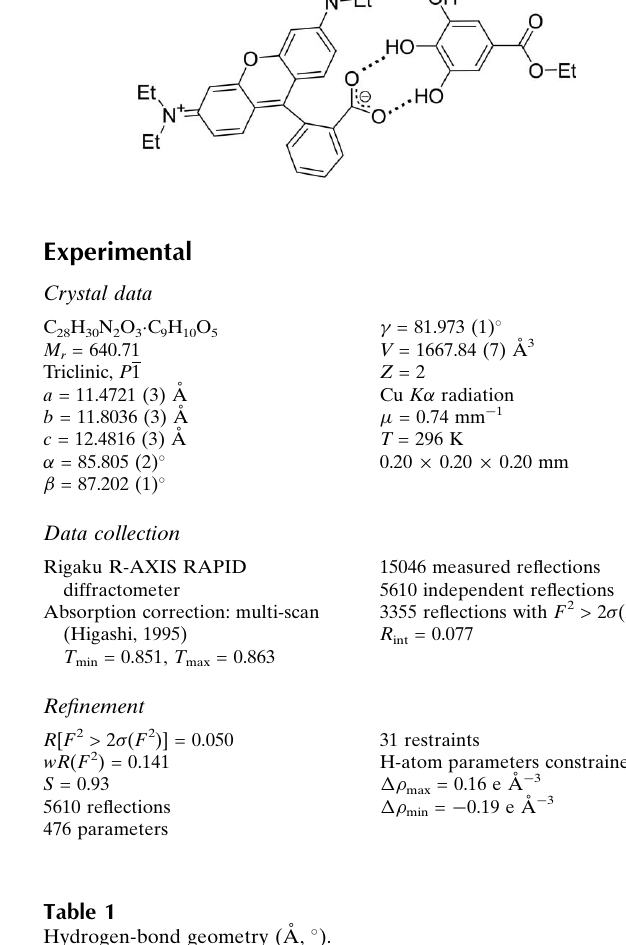
Hydrogen-bond geometry (A˚ , (cid:2) ). D —H (cid:1)(cid:1)(cid:1)